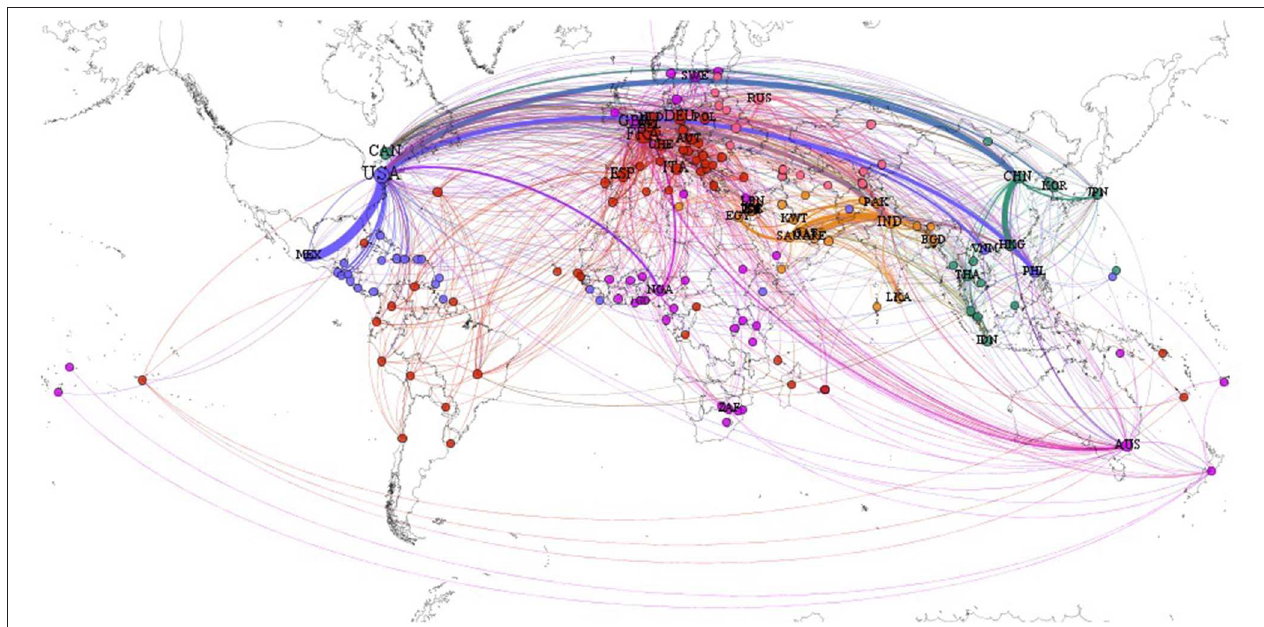
FIGURE 5 | The regional community structure in GRN. Notes: The coloring of nodes and their linkages are the same for each community, i.e., red for C1, purple for C2, blue for C3, orange for C4, green for C5 and pink for C6. The size of a linkage corresponds to the magnitude of remittance flow.